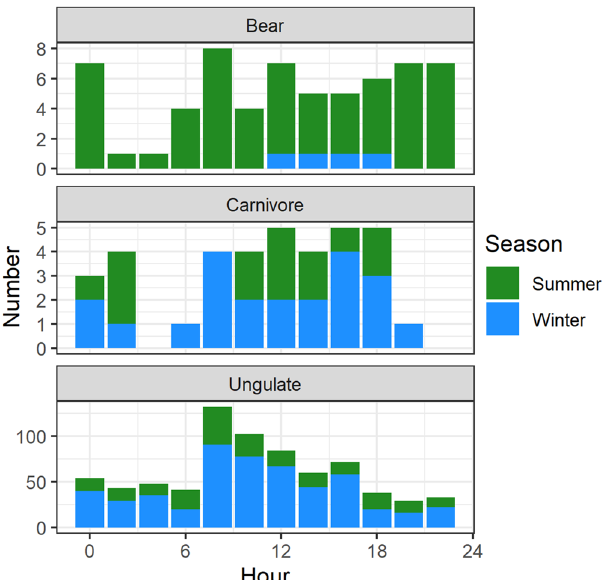
Figure 4. Number of mortalities recorded by hour of the day between 1995 and 2018 for three guilds of large mammals struck on the railway through Banff and Yoho National Parks,